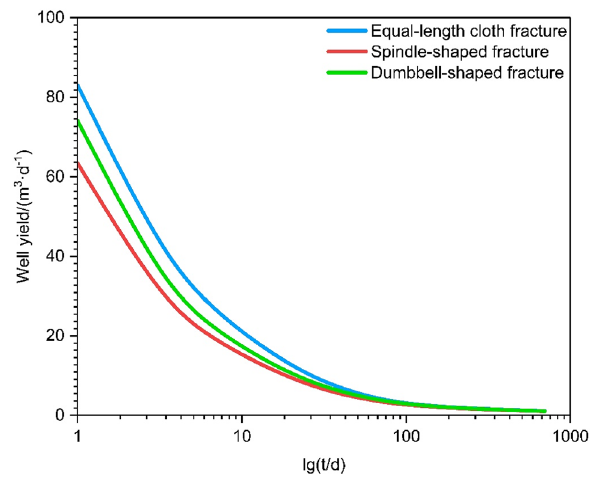
Fig. 12 Well production curves for different hydraulic fracture